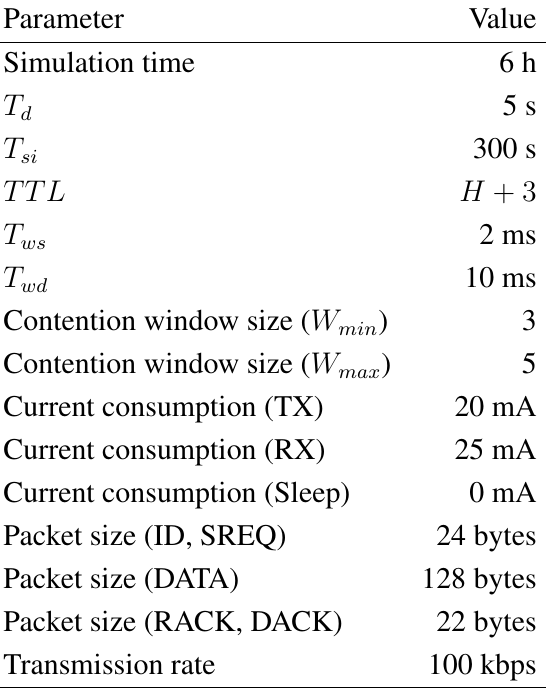
Table 1. Parameter